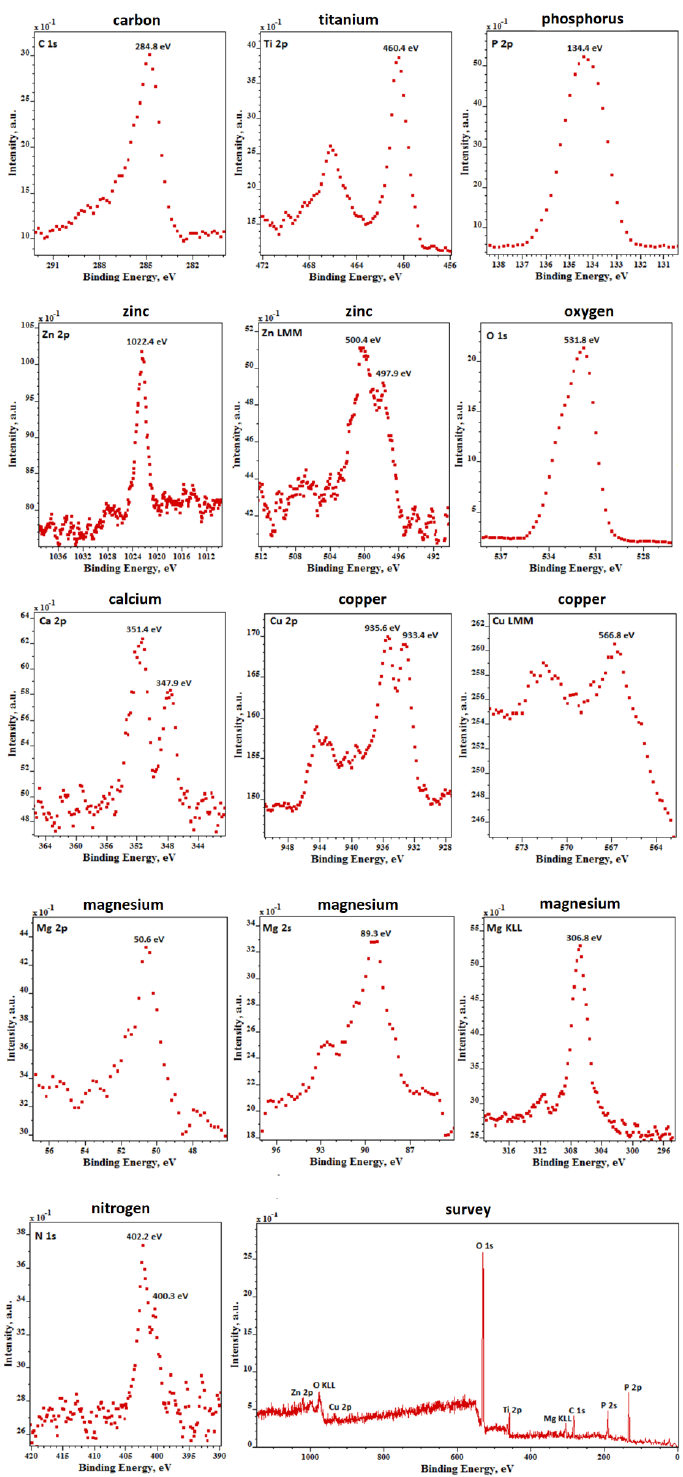
Figure 3. XPS spectra of coatings formed on CP Titanium Grade 2 after PEO process at voltage 575 V DC in 1 L of 85% H 3 PO 4 with additions of 125 g Ca(NO 3 ) 2 · 4H 2 O, 125 g Mg(NO 3 ) 2 · 6H 2 O, 125 g Zn(NO 3 ) 2 · 6H 2 O, and 125 g Cu(NO 3 ) 2 · 3H 2